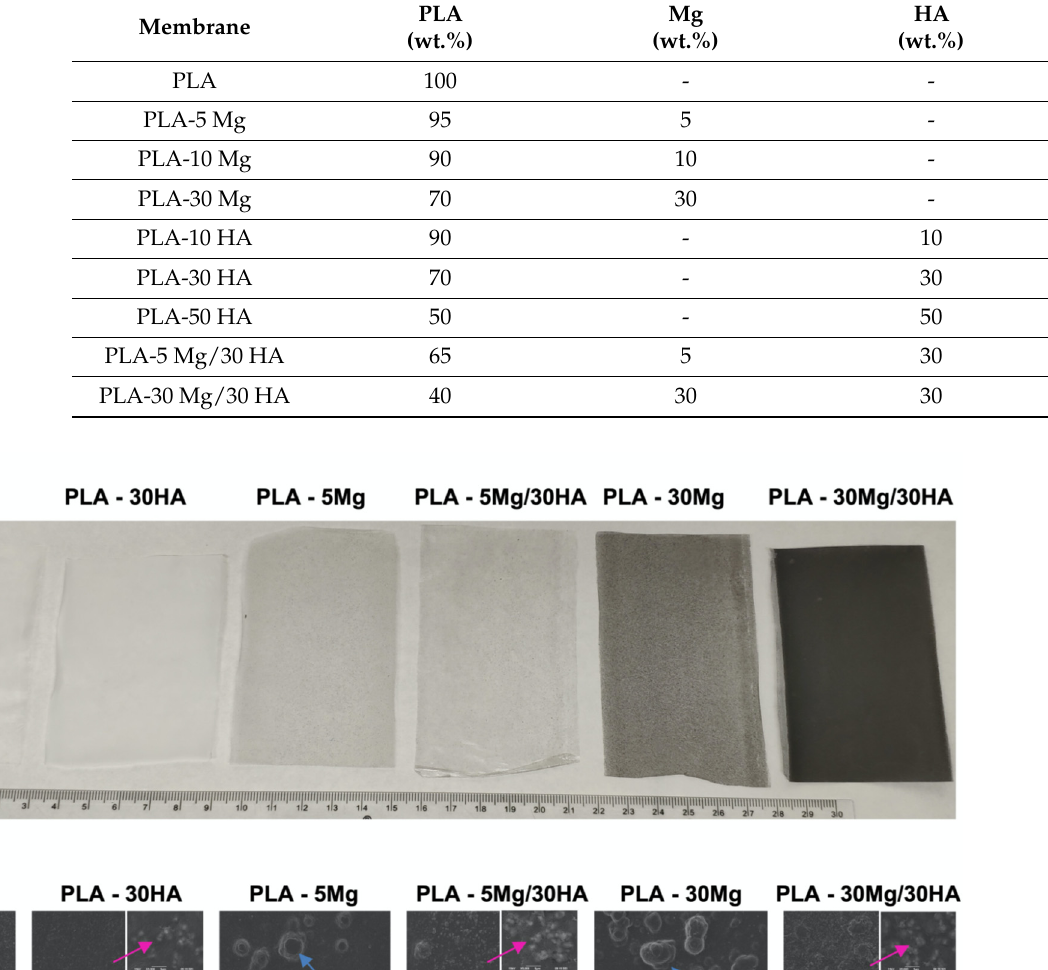
Table 1. Membrane compositions (nominal values).